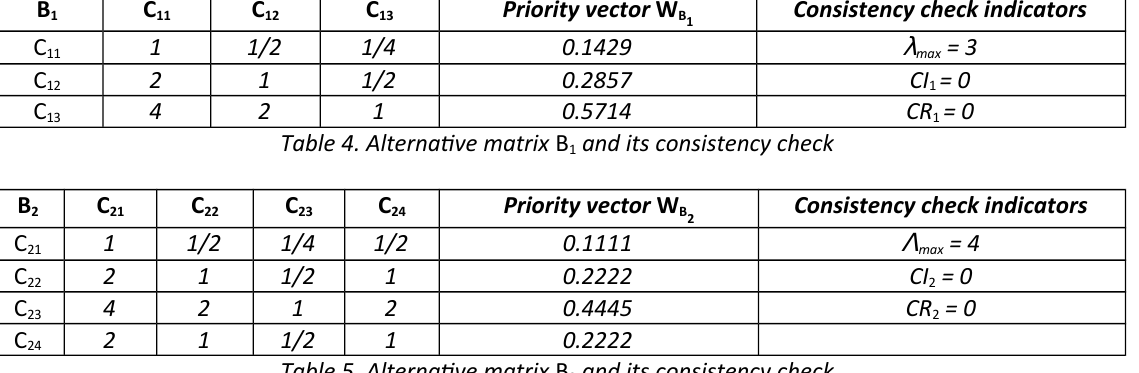
and its consistency 2